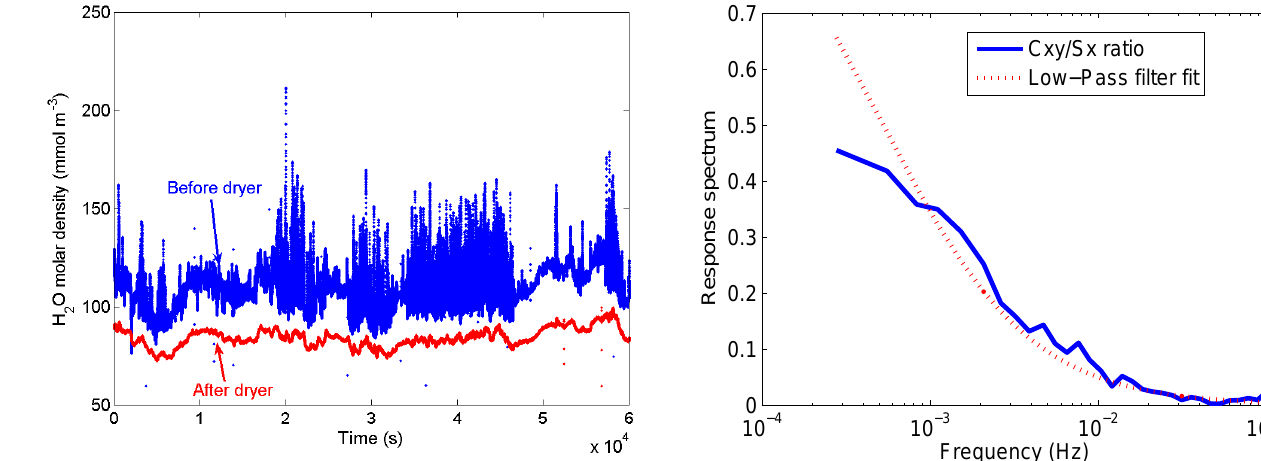
Fig. 12. Ratio of the cospectrum between the two LI-CORs before and after the Nafion ( C xy ) divided by the variance spectrum of the LI-COR before the Nafion ( S x ). The dash line is a first-order low- pass function fit (with a time constant of